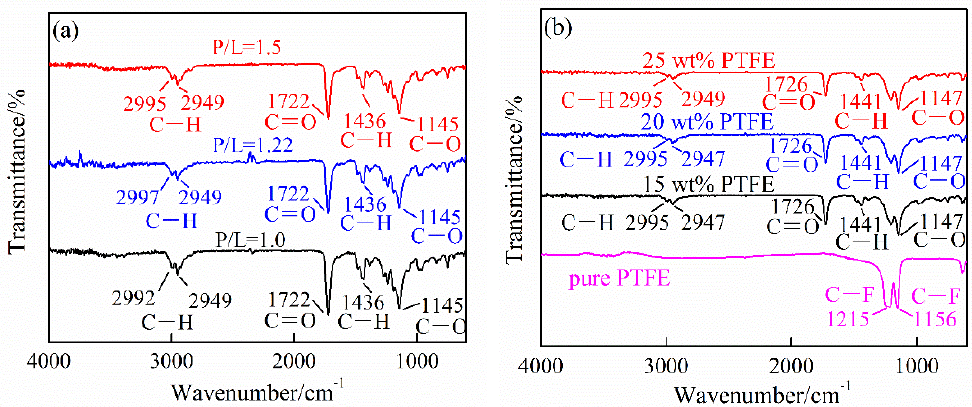
Figure 3. Fourier transform infrared (FTIR) spectra of ( a ) the unfilled PMMA synthesized by the different P/L ratios and ( b ) the PTFE/PMMA composites (P/L = 1.5) and pure PTFE.